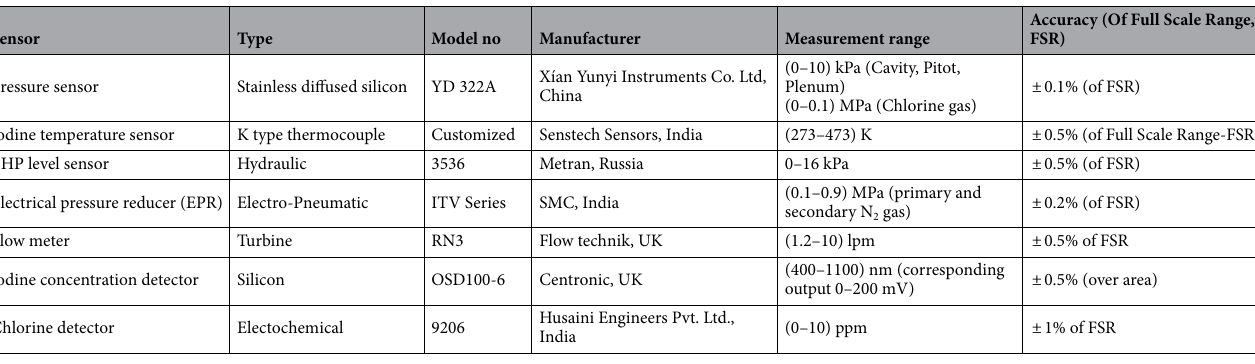
Table 1. Features of the sensors/detectors used in COIL operation using DAAS.